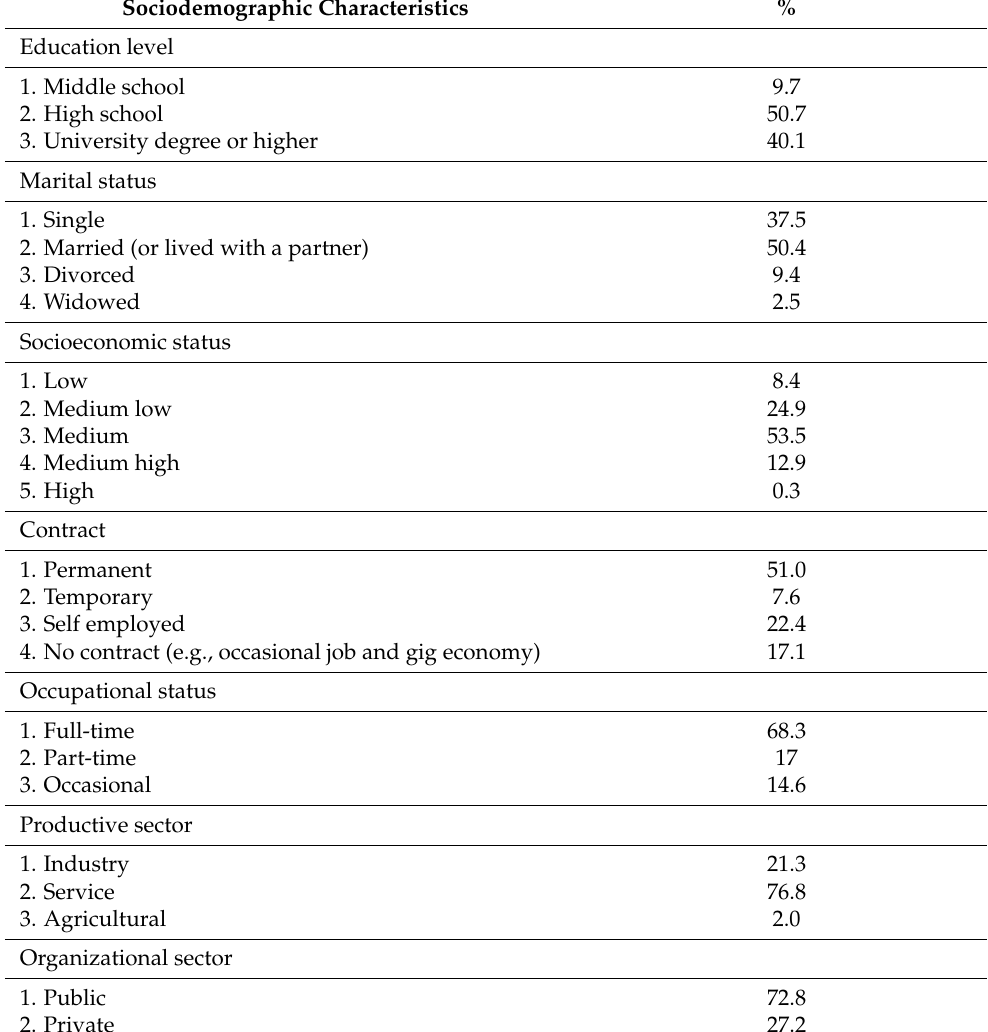
Table 1. Sociodemographic features of the sample ( n =